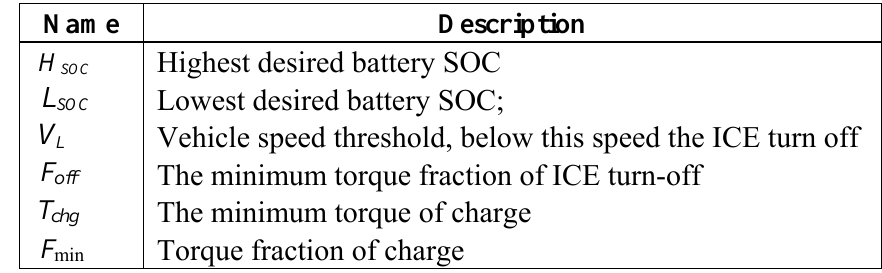
Table2. Main variables of the control